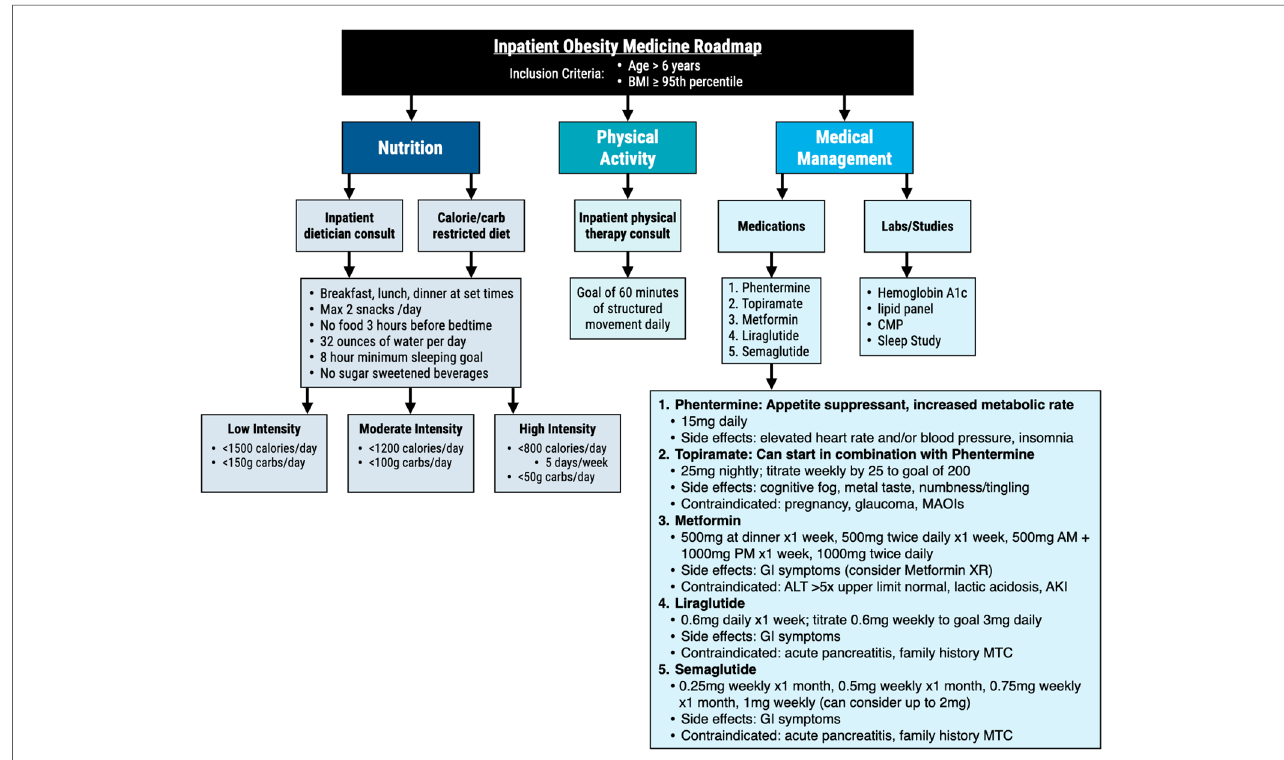
FIGURE 2 Model of inpatient obesity treatment roadmap with collaboration of obesity medicine specialists (MD/NP), nutritionists, nurses, and physical therapists to create individualized nutrition, activity, and medical plans for pediatric patients. BMI, body mass index; CMP, comprehensive metabolic panel; MAOI, monoamine oxidase inhibitors; XR, extended release; AKI, acute kidney injury; MTC, medullary thyroid carcinoma; GI,